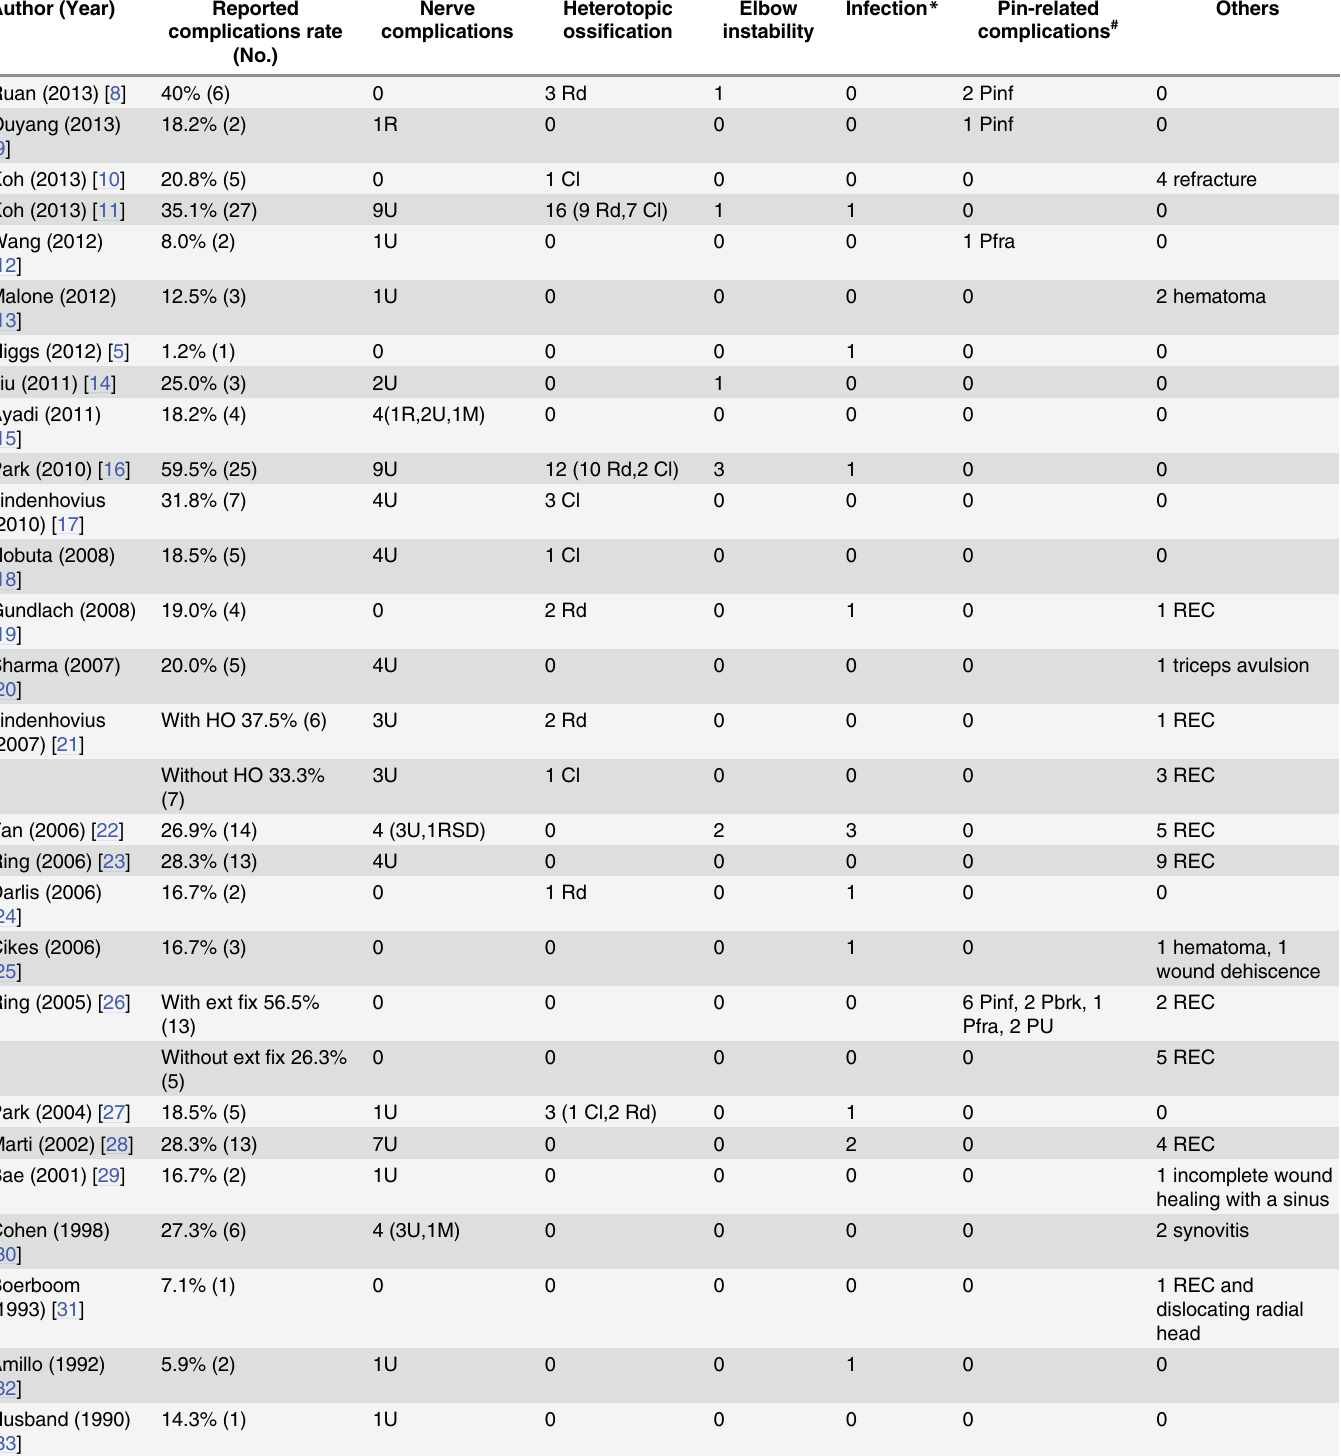
Table 2. Breakdown of complications reported in each of the selected